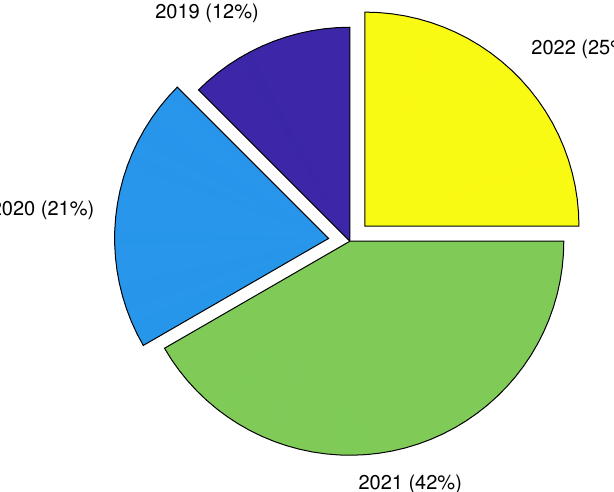
Figure 6. Year-wise distribution of the publication from 2019 to April